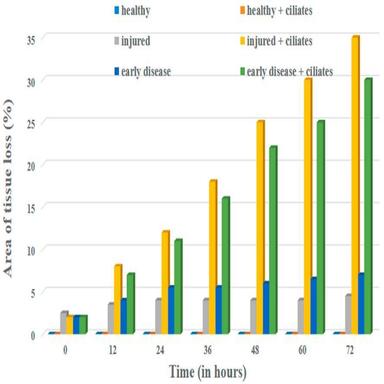
Tissue loss of Acropora sp. inoculated with and without ciliates. Artificially injured and early disease sign Acropora without ciliates was observed for minimal level of tissue loss. The ciliates inoculated early disease sign and injured Acropora were observed for the high percentage of tissue loss under increased time series. No tissue loss were observed in only healthy and healthy inoculated with ciliates.